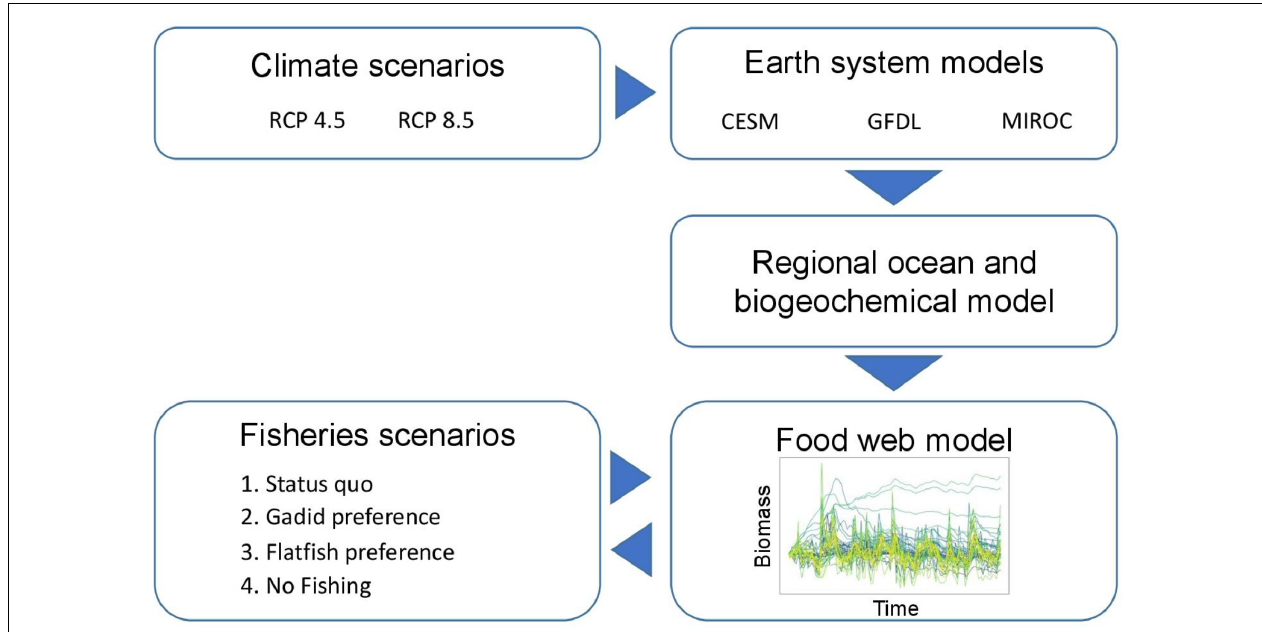
FIGURE 1 | Overview of the ACLIM modeling framework as implemented with our food web model. The outputs from three earth system models, each driven by two IPCC AR5 climate scenarios (RCP 4.5 and 8.5), are dynamically downscaled and used to drive a regional ocean and biogeochemical model through the end of the century. The outputs from the lower trophic level modeling are used to simulate the biomass dynamics of phytoplankton and zooplankton groups in the food web model. The food web model is coupled to a fisheries sub-model that dynamically predicts annual commercial fisheries catch in response to the simulated stock status and under four different quota allocation